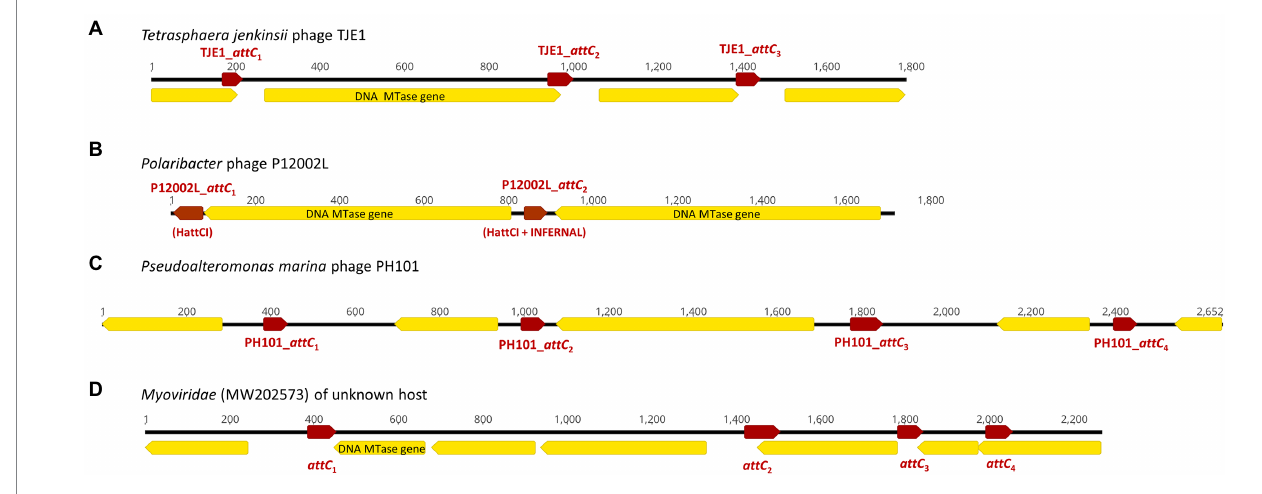
FIGURE 2 Examples of CALINs found in both virulent and temperate phages with structures that resemble integron gene cassette arrays in bacterial integrons. The open reading frames (ORFs) are shown in yellow, while the attC sites are represented by red arrows. ORFs encoding predicted DNA methyltransferases (MTase) are annotated. (A) CALIN in the virulent Tetrasphaera jenkinsii phage TJE1 contains 4 ORFs and 3 attC sites with the typical structure of an integron gene cassette array. (B) Two predicted DNA MTase genes were found in the CALIN of the virulent Polaribacter sp . phage P12002L. The attC sites were predicted with HattCI (P12002L_ attC1 ) and HattCI + INFERNAL (P12002L_ attC2 ). The latter showed attC x attI1 recombination activity. (C) CALIN in the virulent Pseudoalteromonas marina phage PH101. (D) CALIN in a Myroviridae phage (GenBank MW202573) of unknown bacterial host with a putative DNA MTase